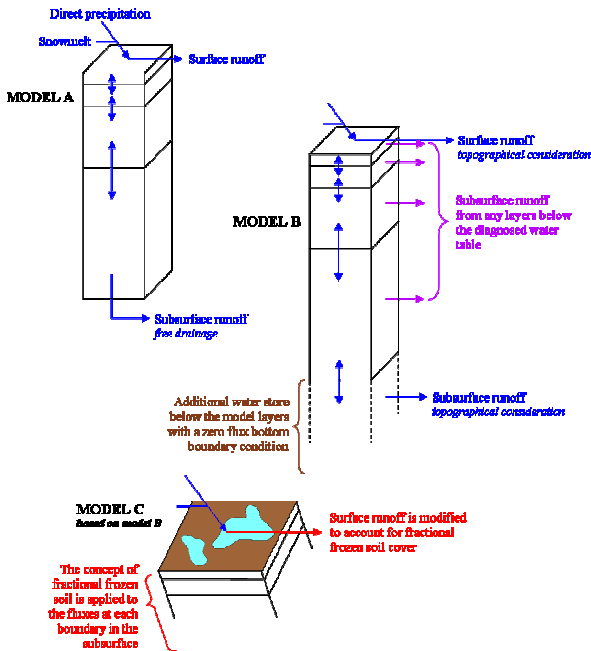
Fig. 3. A schematic diagram outlining the key differences between the models used in the study. “Model A” is the standard JULES structure, “Model B” uses an option within JULES to include a water table and topographic effects on hydrology (TOPMODEL), and “Model C” further modifies TOPMODEL to include FPA and SIMTOP. SIMTOP is not described in the diagram because it has the same structure to TOPMODEL but uses different equations as described in Sect. 2.